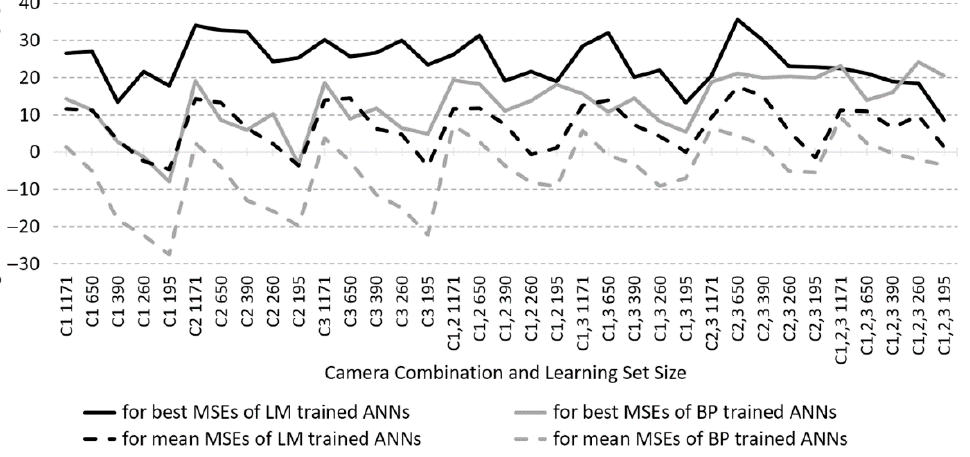
Figure 5. Average of normalised differences between MSE performances of ANNs with one and ANNs with two hidden layers, according to best or mean test set MSEs and using BP or LM training algorithm.